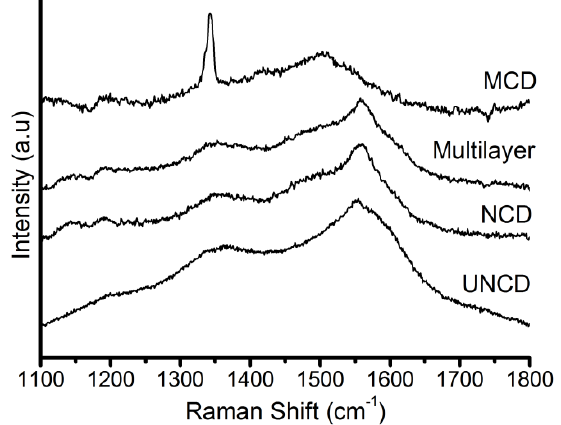
Figure 2. Typical micro-Raman spectra of NCD, MCD, UNCD, and multilayer